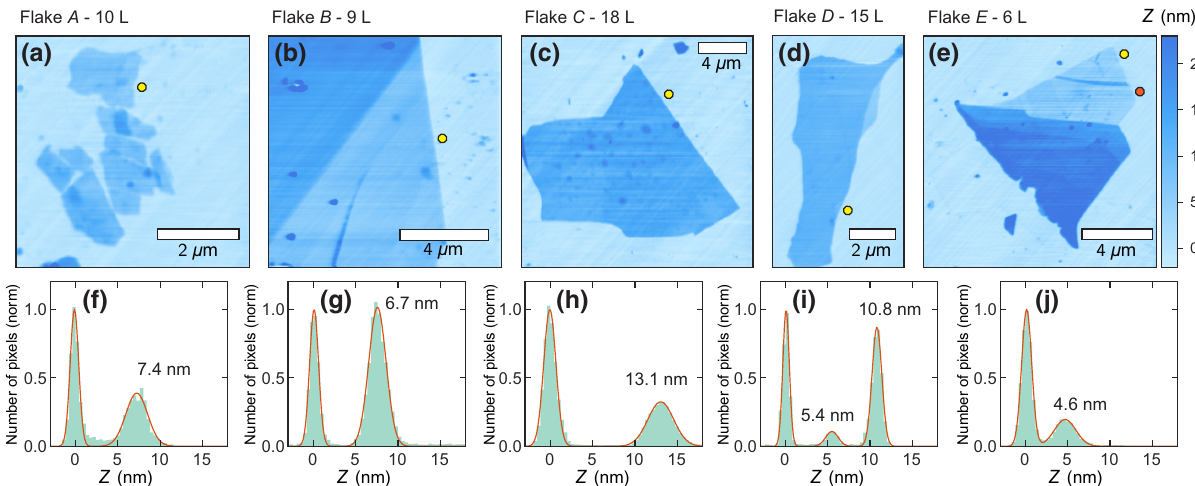
FIG. 8. (a)–(e) AFM topographies of CrBr 3 flakes investigated in this work. (f)–(j) The step height histogram with Gaussian peak fitting is shown below the corresponding AFM topography and is used to determine the flake thickness. NV center magnetometry is predominantly performed at the location indicated by the yellow or red dot plotted in the AFM topography. For Flake E (six layers), the dc hysteresis is measured at two different locations along the edge of the